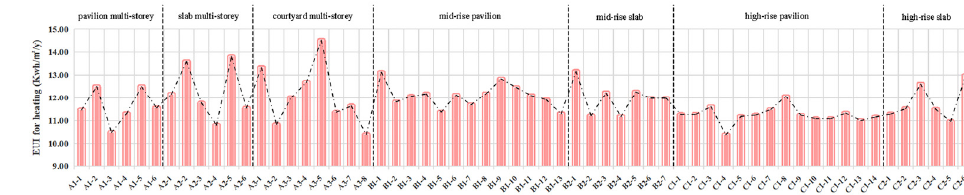
Figure 14. Distribution characteristics of EUI for heating in seven typologies of office blocks.